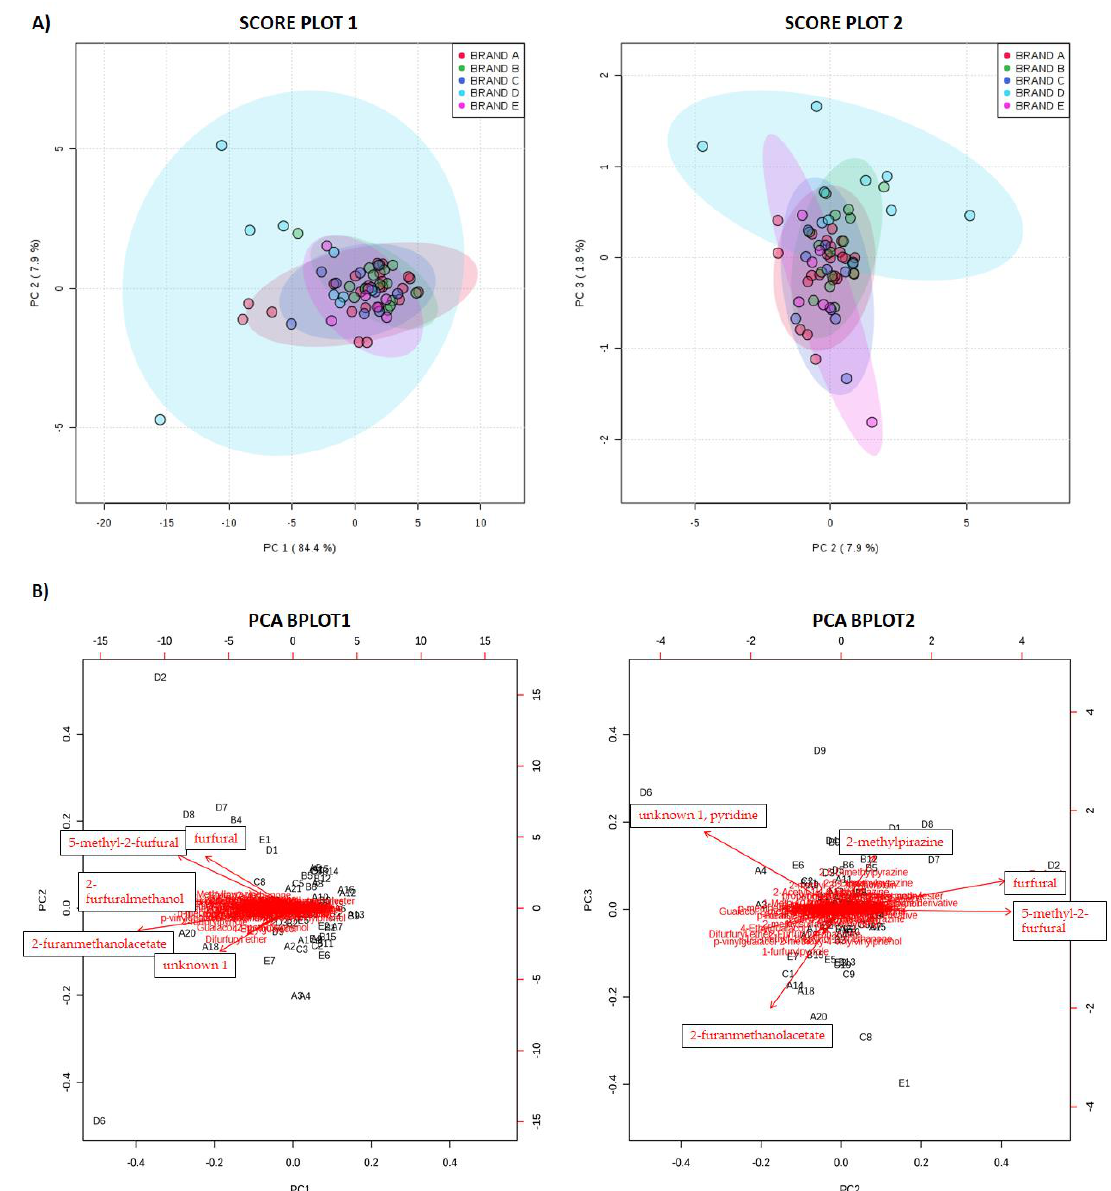
Figure 2. Principal component analysis (PCA) results for volatile profiles in EC brewed by capsules from 5 commercial Italian brands; ( A ) SCORE PLOT1: 2D score plot for PC1 and PC2; SCORE PLOT2: 2D score plot for PC2 and PC3; the ellipse represents the confidence around each of the brands. ( B ) PCA BPLOTS including the position of each sample for PC1 and PC2 (PCA BPLOT1) and for PC2 and PC3 (PCA BPLOT2) and how variables map onto these.